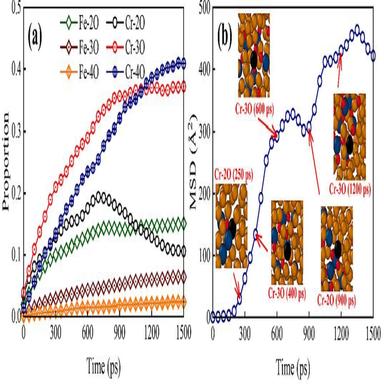
Fe/Cr atoms bonded with n O are recorded as Fe-nO/Cr-nO in the simulation. (a) The proportion of Fe-nO and Cr-nO in the near-surface region (40 Å). (b) Mean squared displacement of the selected Cr atom/ion during the corrosion process.